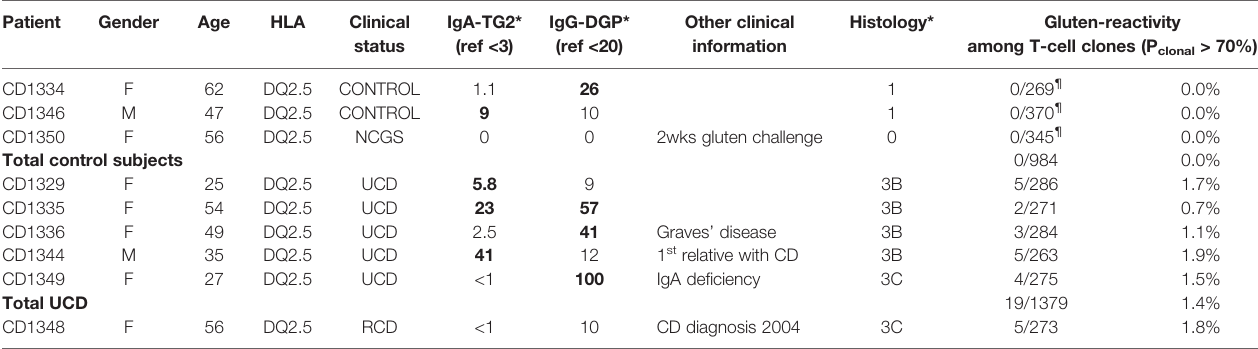
TABLE 1 | Patient characteristics and frequency of gluten-reactive T